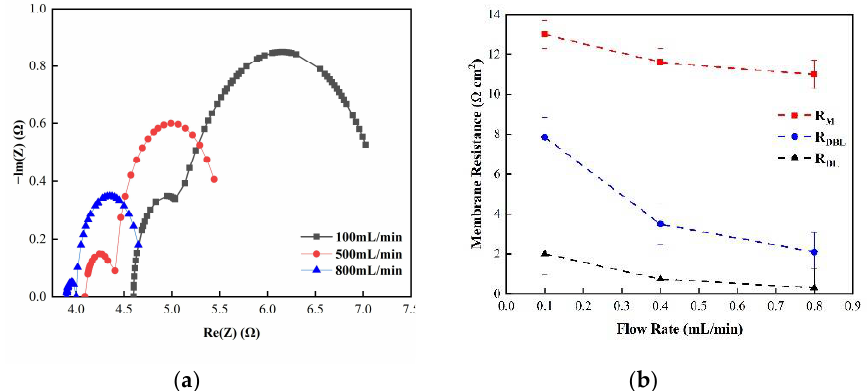
Figure 10. ( a ) The impedance of the Nyquist spectrum and ( b ) the membrane impedance R M , double layer impedance R DL , and diffusion layer impedance R DBL of the CEM membrane in 0.5 M NaCl solution.